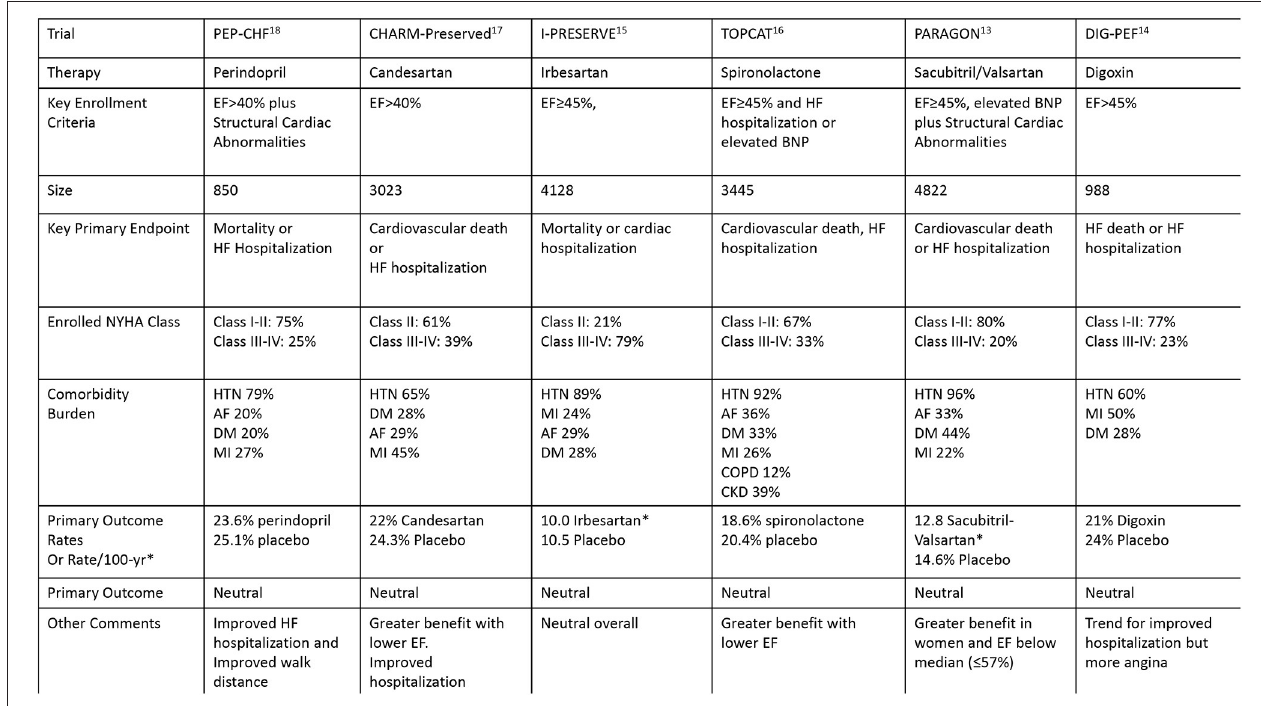
FIGURE 2 | Key clinical trials involving patient with